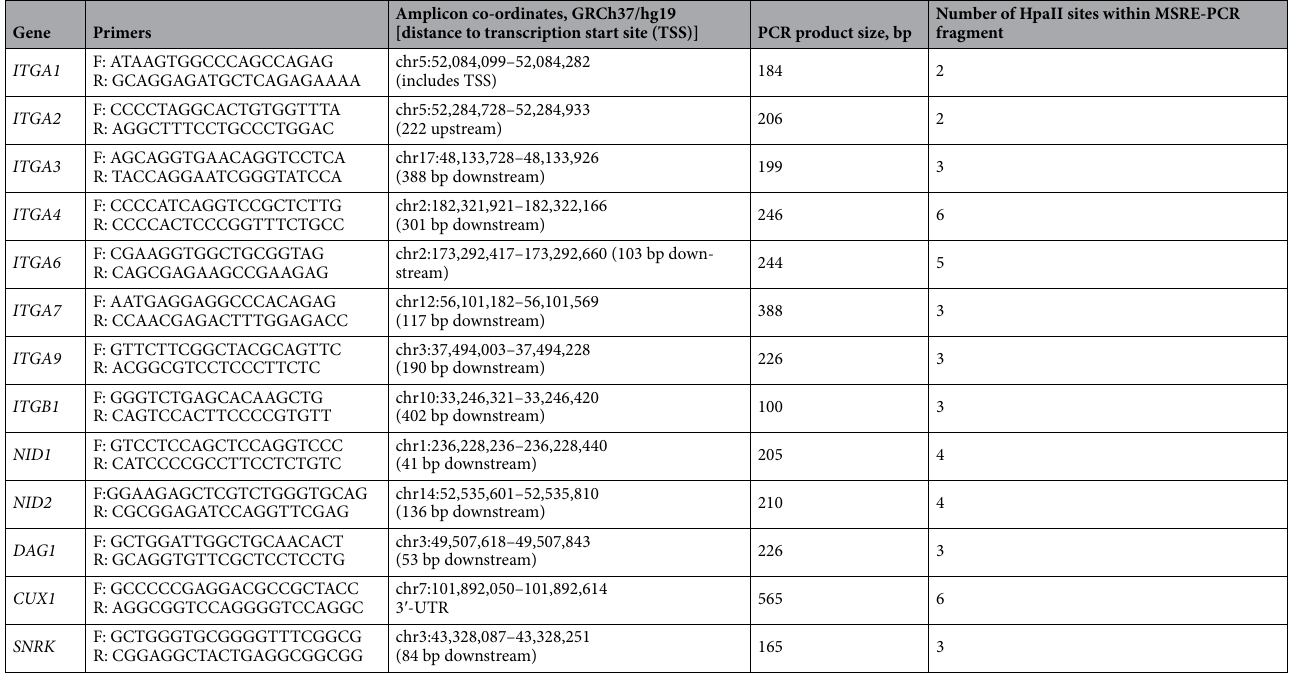
Table 4. Primers used to assess the methylation status of the integrin, nidogen, and dystroglycan genes by methylation-sensitive restriction enzyme digestion PCR.